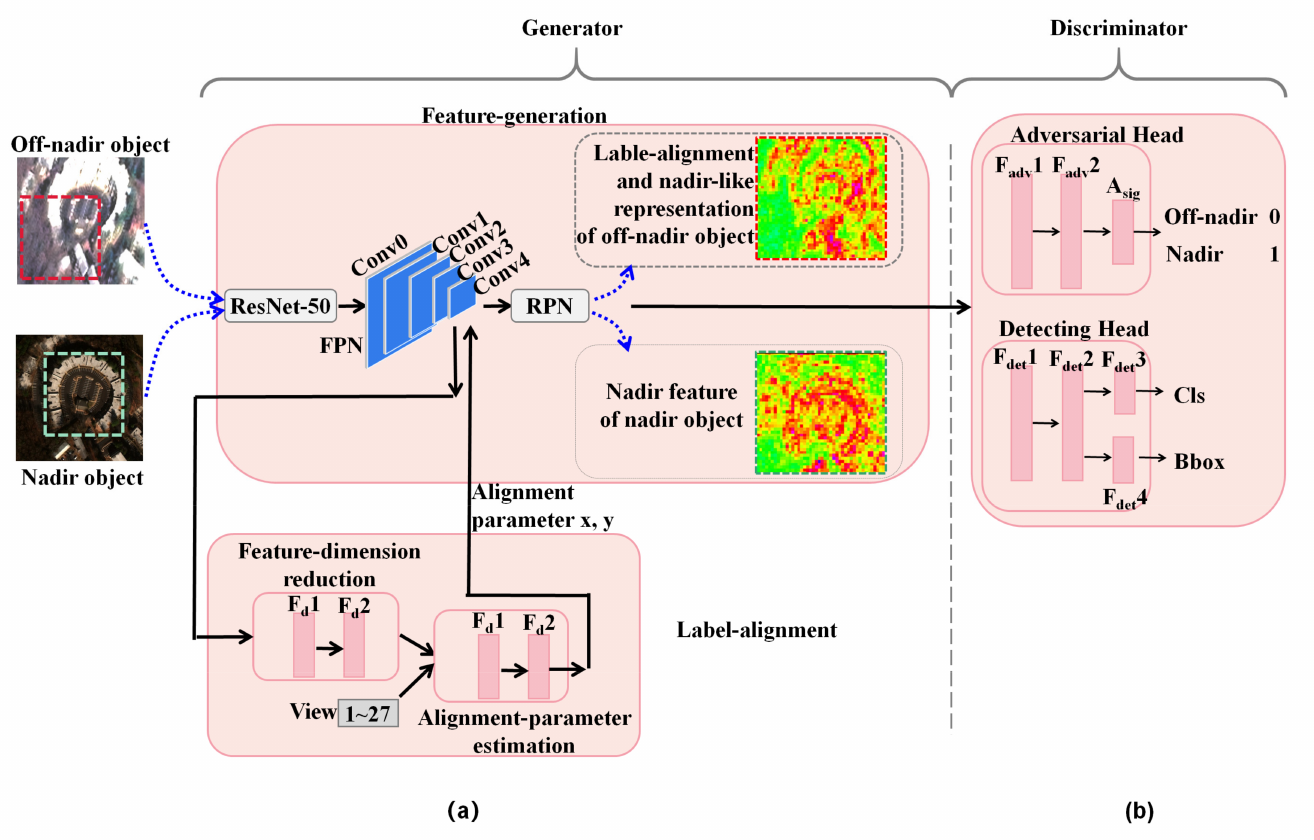
Figure 4. The network architecture of NaGAN. ( a ) The feature generation in the generator consists of the ResNet-50 backbone network, FPN, and RPN. The label alignment takes features learned from the FPN high-level layer conv4 as the input. Then, the features are sent to feature-dimension reduction to decrease the feature dimension. After that, the new low-dimensional features are then fed to alignment-parameter estimation to regress the label-alignment parameters. ( b ) The discriminator takes the features of the nadir object and the nadir-like representation of the off-nadir object as inputs. The adversarial head comprises two fully connected (FC) layers and sigmoid activation sequentially. The detection head is constituted by two FC layers and subsequently two output layers, and the latter are employed for bounding box regression and classification,